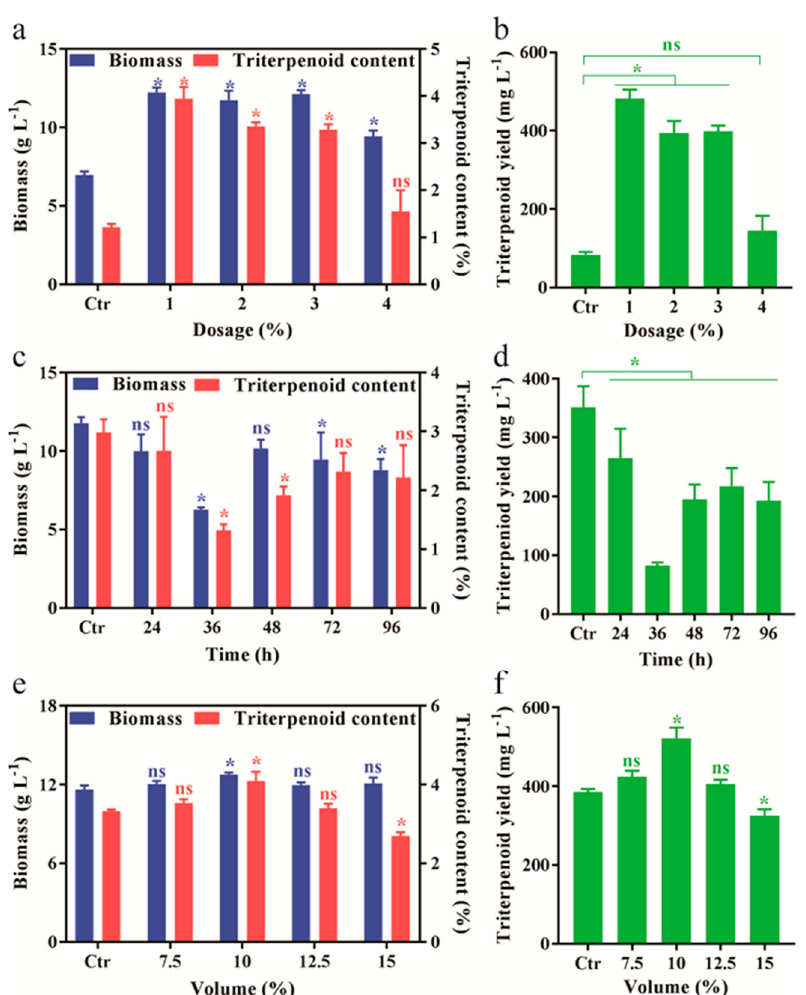
Figure 2. Optimization of the liquid fermentation of A. cinnamomea with corn oil. The effect of oil dosages ( a , b ), addition time ( c , d ), and inoculation volume of mycelia ( e , f ) on biomass and triterpenoid content, and triterpenoids yield, was quantitatively analyzed, respectively. The fermentation without oil, 0 h addition of 1% ( v/v ) corn oil and 5% ( v/v ) inoculation volume is considered as the control in a and b, c and d, and e and f, respectively. All fermentation was conducted at 28 °C for 12 days. All data were from triplicates (means ± SD). Asterisks denote ( * p < 0.05) statistically significant differences between treatment groups and the control, ns indicates no significant difference.